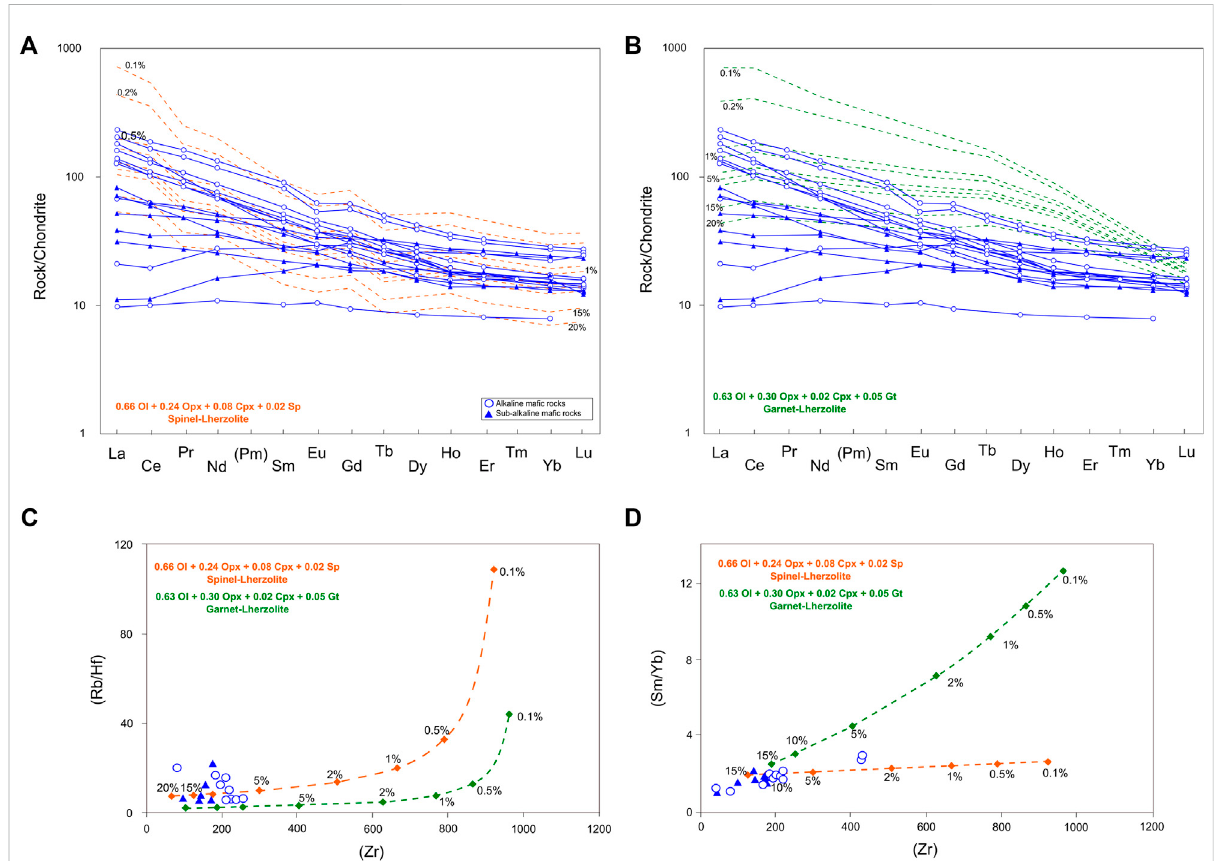
FIGURE 8 (A) Chondrite-normalizedpartialmeltmodelforma fi cmagmasfromtheMGVFshowingpartialmeltingcurvesofspinel-bearinglherzolitemelt. (B) Chondrite-normalized partial melt model for ma fi c magmas from the MGVF displaying partial melting curves of garnet-bearing lherzolite melt. Partial meltcurves were generated atthedegree of melting F=0.01 – 0.2 , applying batch melting equations reported by Zou(2007). Moredetails are given in the text. The chondrite and primitive mantle values from normalization are taken from McDonough and Sun (1995). (C) ( Zr) vs. (Rb/Hf) bivariatediagramshowingpartialmeltmodelforma fi cmagmasfromtheMGVF.Themeltingcurvesaregeneratedatthesamedegreesofmelting